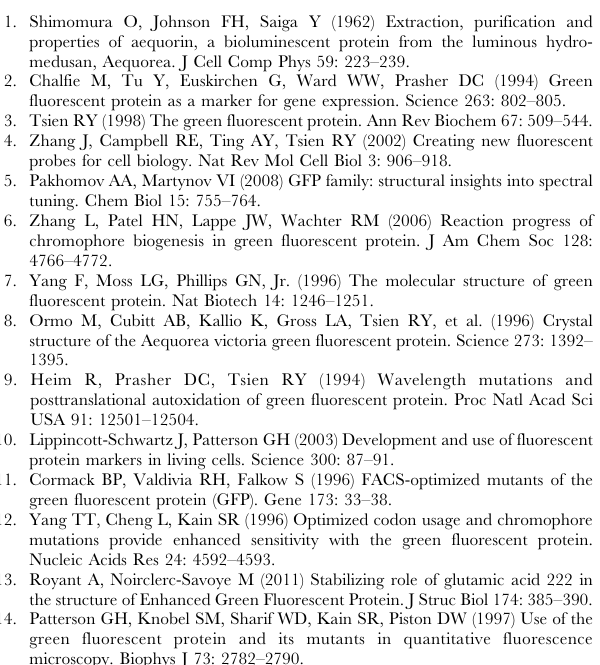
Figure S5 Structural comparison of L18 and L44 in the present structure (4EUL) and 2Y0G. Overlay of the single observed conformer of Leu18 (A) or L44 (B) for 2Y0G [S1] with conformer A (green) and conformer B (red) observed in the present study (4EUL). Table S1 Secondary structure assignment for EGFP and wt